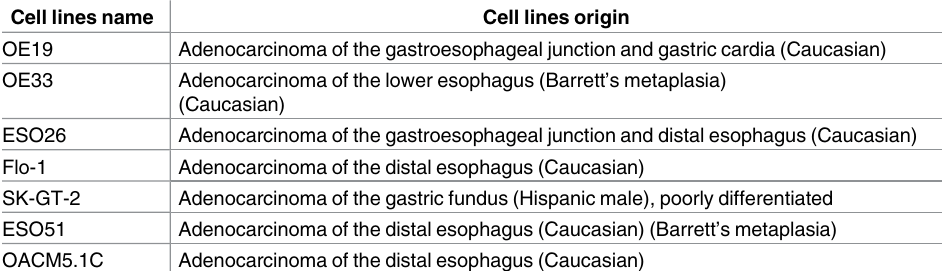
Table 1. Cell lines used to establish peritoneal dissemination xenograft mouse model of esophageal adenocarcinoma. Cell lines